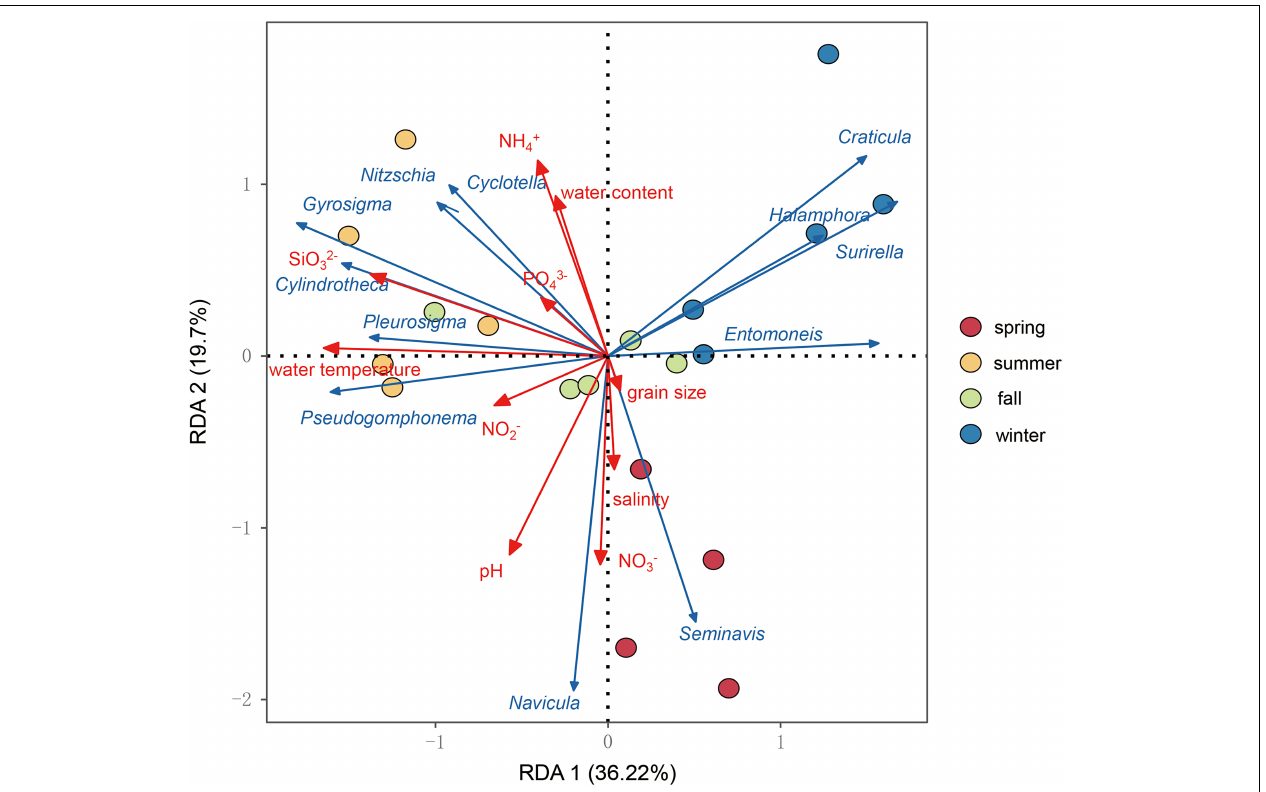
FIGURE 8 | Results of redundancy analysis graph for the environmental variables associated with changes in the benthic diatom community structure in the Yellow River Delta.